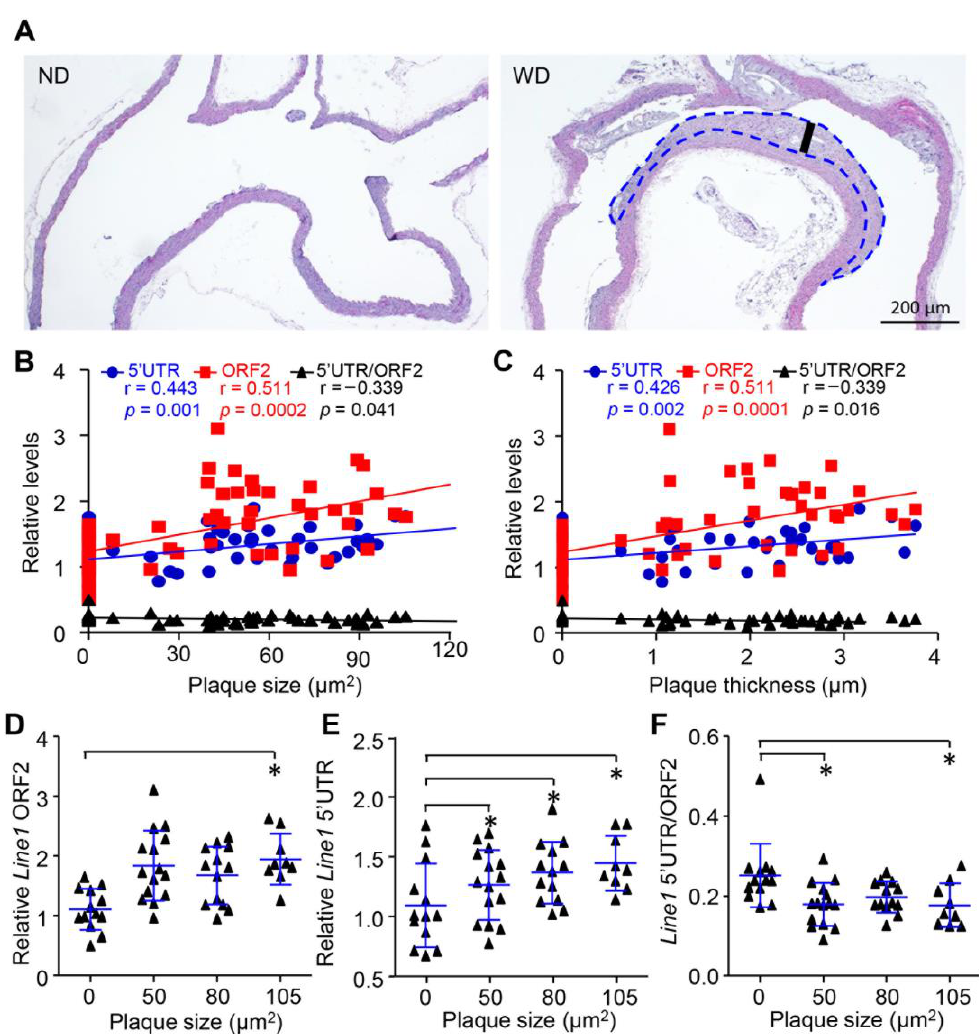
Figure 4. Release and cleavage of cfDNA was associated with plaque progression in vivo. ( A ), HE staining of aorta from ApoE − / − mice fed with WD and ND for 6 months. ( B , C ) Spearman correlation for cfDNA concentration correlated with carotid plaque size (B) and thickness ( C ). ( D , F ) Levels of short fragment ( D ), long fragment ( E ) and integrity ( F ) of cfDNA among different levels of plaque size. Data are shown as mean ± SEM and were evaluated by unpaired t test. * p < 0.05.